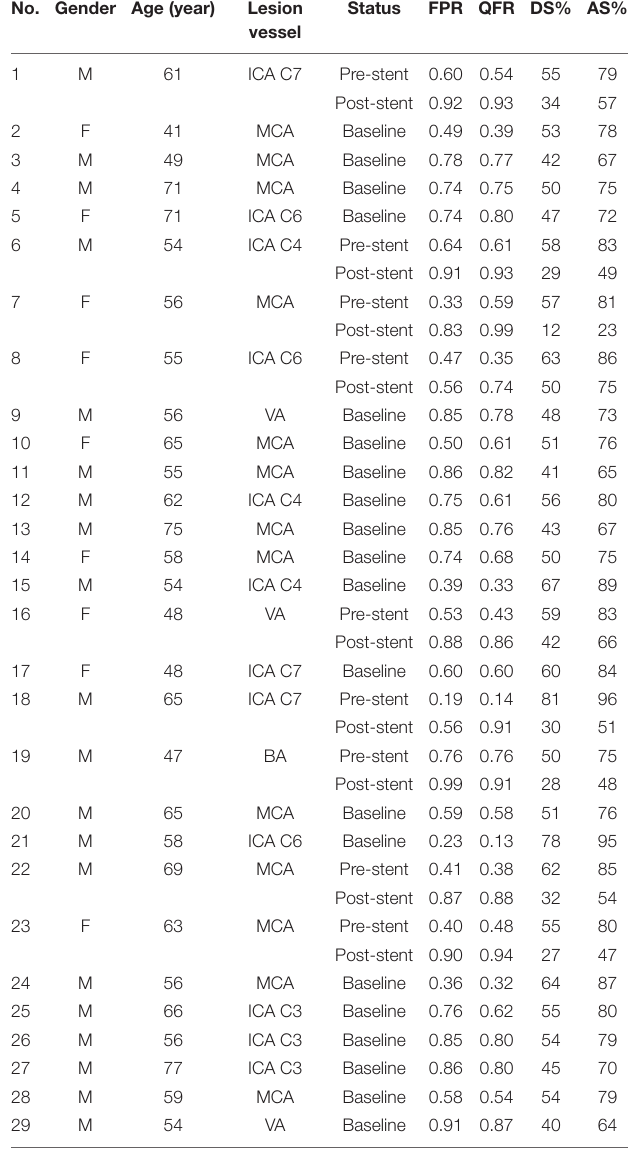
TABLE 1 | Baseline information and the results of FPR and QFR.